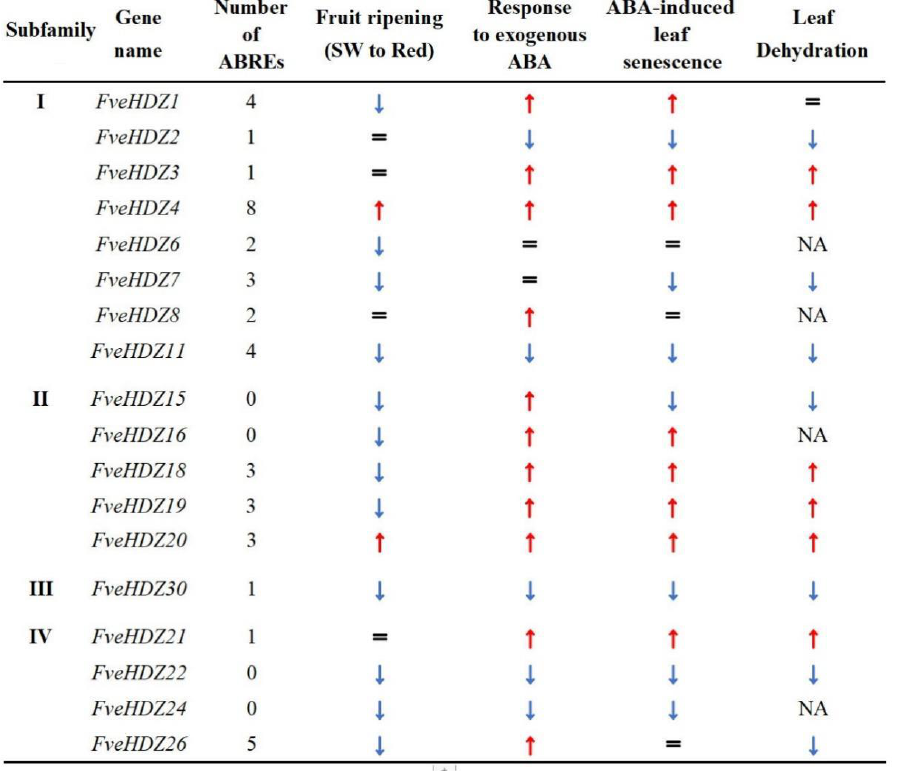
Figure 7. Summary of expression patterns of the selected 18 FveHDZs in the four ABA-mediated processes. Red “ ↑ ” , blue “ ↓ ” , and black “ = “ indicate ≥ 1.5-fold up-regulated, ≥ 1.5-fold down-regulated, and almost unchanged expressions, respectively. Results of the fruit ripening process were based on the transcriptome data from Gu et al. [43] (Figure 3c). Results of the other three processes were based on the RT-qPCR analyses in this study (Figures 4 – 6). NA, Not examined; ABRE, ABA-responsive element; SW, Small white stage.